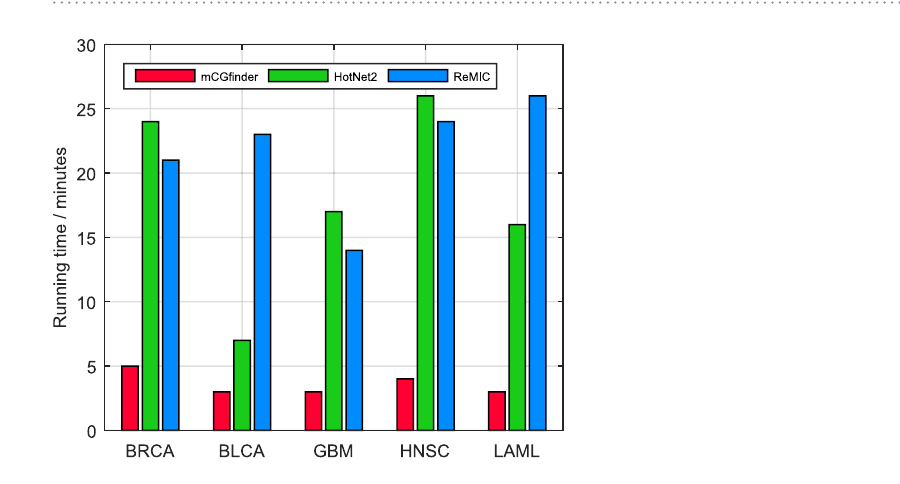
Figure 5. Running time comparison of mCGfinder (red bar), HotNet2 (green bar) and ReMIC (blue bar) on datasets of BRCA, BLCA, GBM, HNSC and LAML